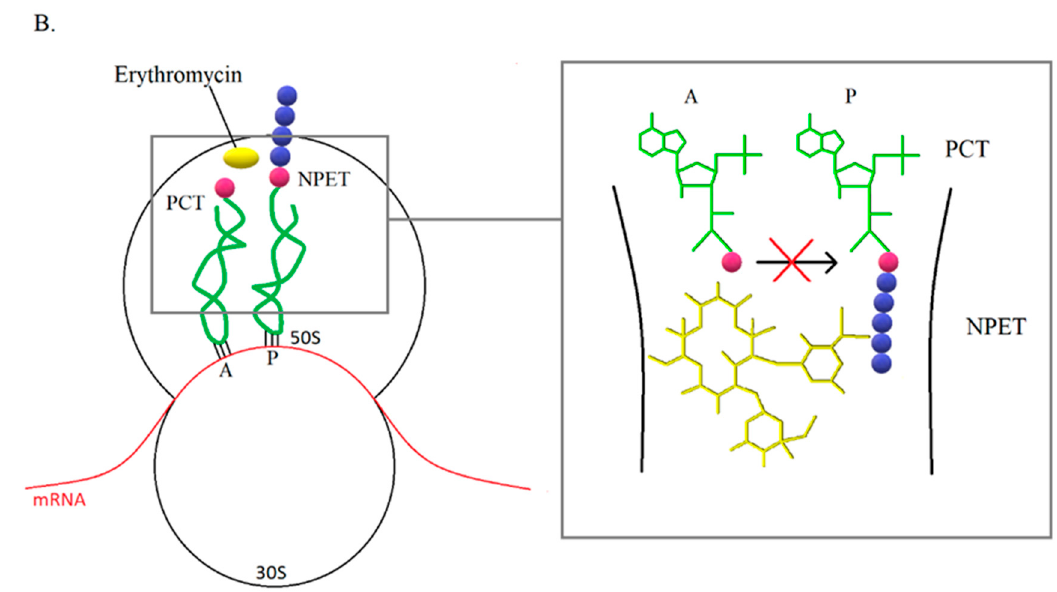
Figure 4. ( A ) The ribosome is a macromolecular complex that transcribes information encoded in mRNA into proteins. In prokaryotes, it consists of two subunits: the smaller (30S) and the larger (50S). The small subunit interacts with the mRNA and reads the genetic information. In turn, the large subunit is responsible for the formation of bonds between subsequent amino acids in the polypeptide chain. At the border of the subunits, there are a-site tRNA ( A ), e-site tRNA, and p-site tRNA (P) attachment sites responsible for translations. An extended polypeptide chain is linked to the P site, while further amino acids are delivered to the ribosome by aminoacyl-tRNA bound at the A site. The phenyl transferase center (PCT) is the center that catalyzes the reaction of polypeptide chain elongation. As each amino acid is added, the polypeptide chain is moved through the NPET. ( B ) The macrolide binding site is NPET near the PCT. For example, erythromycin (yellow), which when bound to the ribosome leads to the termination of the synthesis of the polypeptide chain. Binding of a macrolide antibiotic does not directly affect the protein synthesis process, but prevents further shifting of the polypeptide chain and translation is inhibited [47].